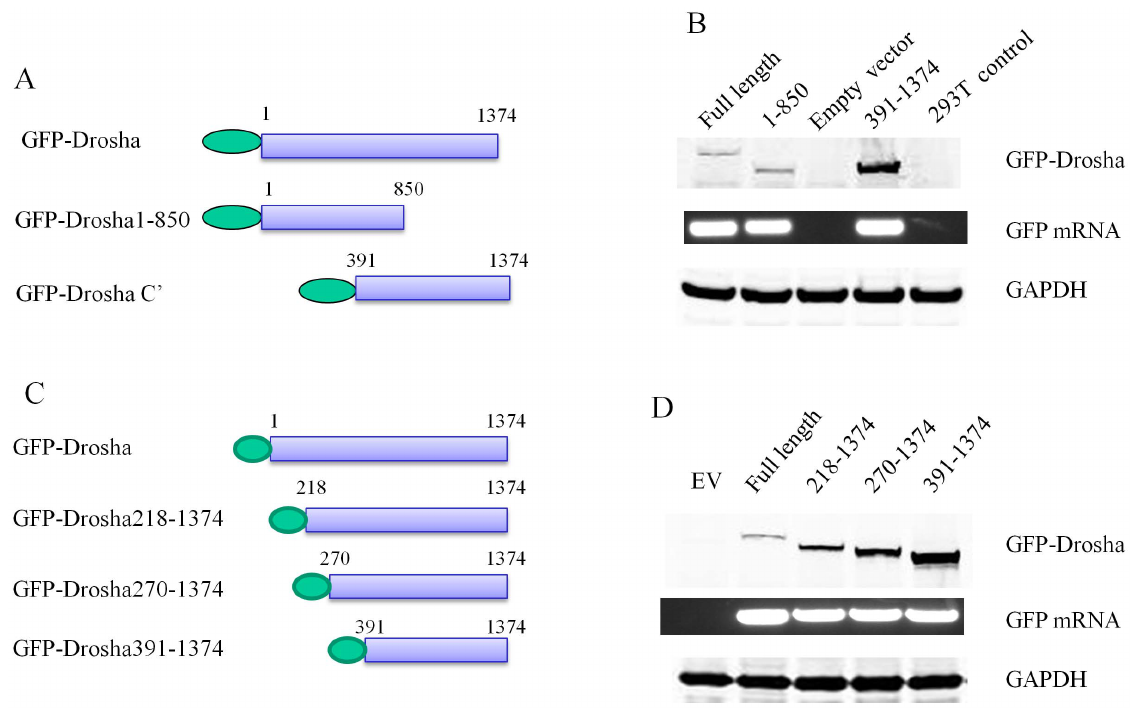
Figure 4. The N-terminus of Drosha is responsible for regulating its degradation. HEK293T cells were transfected with an empty vector, GFP-Drosha wild type or the various mutants as indicated. Forty-eight hours post-transfection, whole cell lysates were prepared for western blot. GAPDH was used as a loading control. All experiments were repeated three times with similar results. ( A&C ) Schematic illustration of domain deletion constructs of Drosha-GFP at the N-terminus. ( B ) GFP-Drosha 391-1374 expressed more protein than GFP-Drosha or GFP-Drosha1-850 indicating N- terminal Drosha harbors a domain regulating expression levels. The mRNA levels of GFP Drosha wt and mutants were measured to monitor the transfection efficiency of various constructs. ( D ) Deletion of additional lysines increased Drosha protein expression, indicating that multiple lysines on the N- terminus regulate Drosha degradation. The mRNA levels of GFP Drosha wt and mutants were measured to monitor the transfection efficiency of various